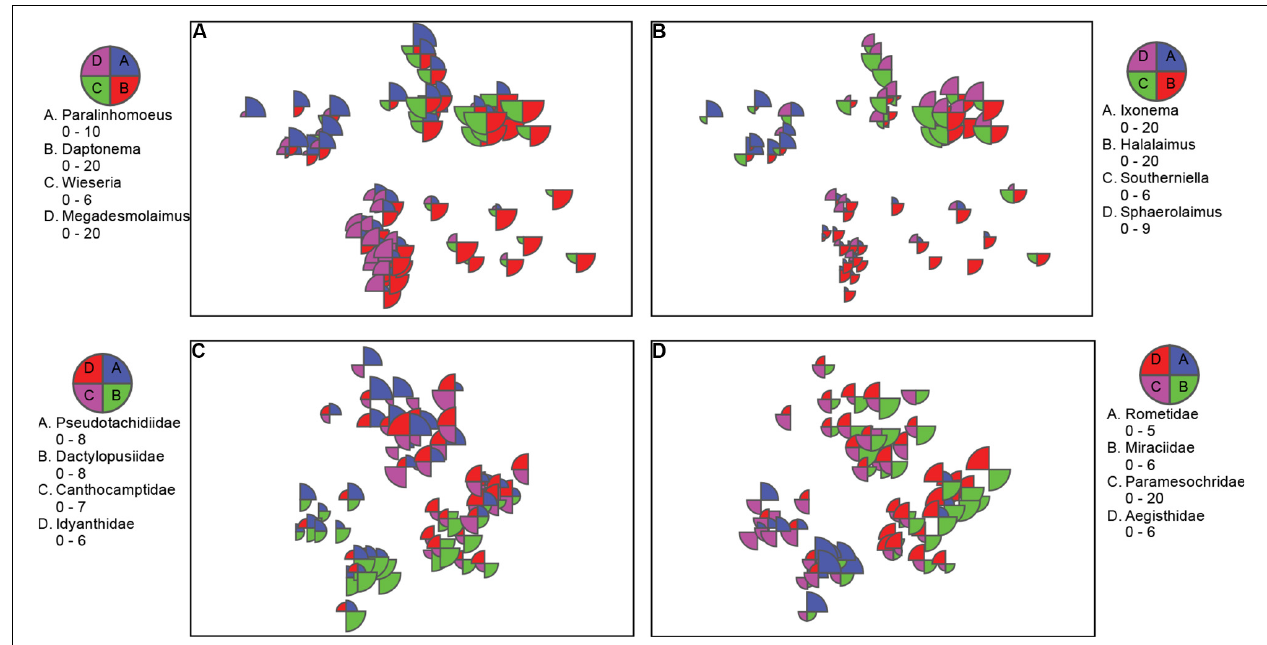
FIGURE 4 | nMDS bubble plots with scaled abundance showing taxa with substantial contributions to location differences. (A,B) Nematode genera from nMDS in Figure 3A ; and C,D ) copepod families from nMDS Figure 3B . Data was standardized, square rooted, and Bray-Curtis resemblance measure was used.